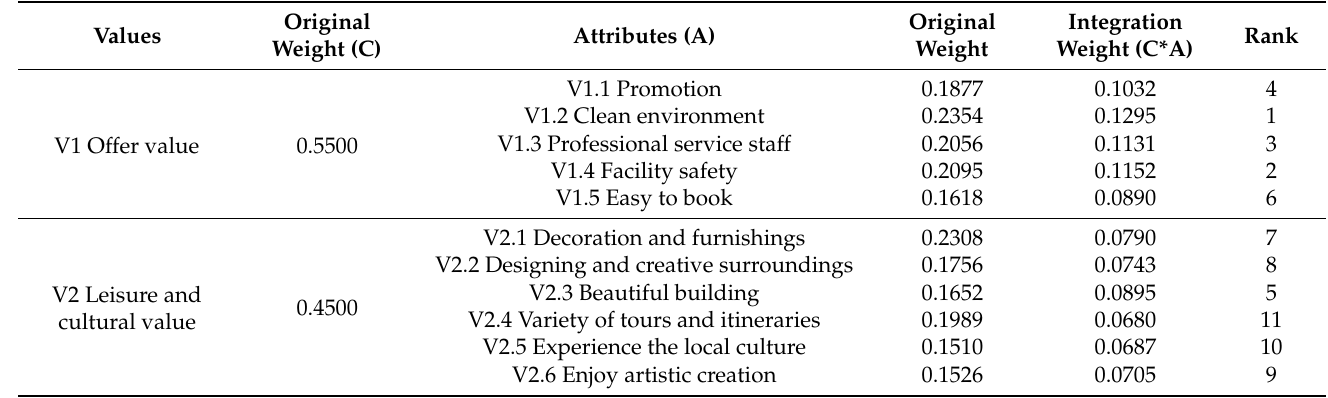
Table 6. Integration weight of each